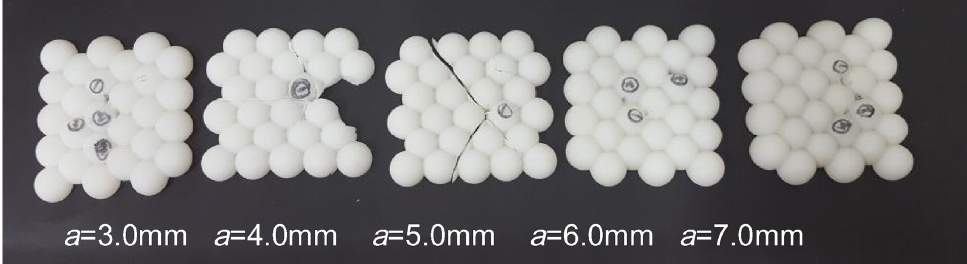
Figure 6. Stab resistant test results of samples with increasingly steeper egg-shell cores (from left to right). Reprinted from [50], Copyright (2018), with permission from Elsevier.